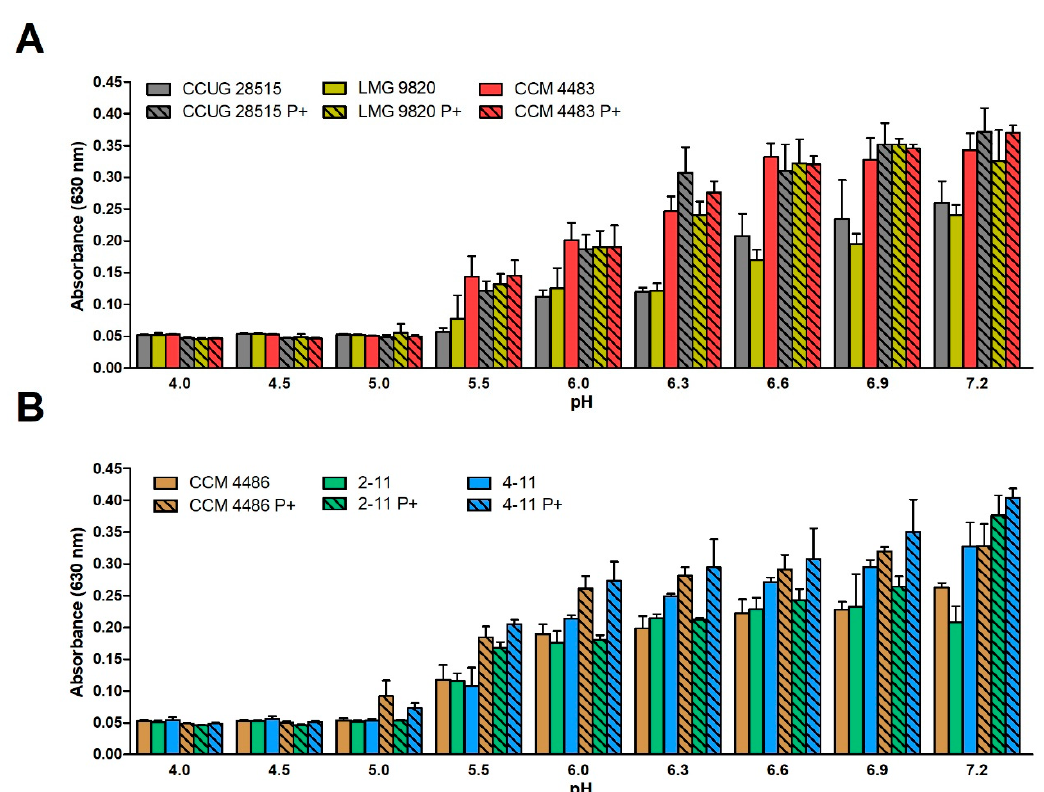
Figure 1. Growth of selected Paenibacillus larvae strains representing two environmentally significant Enterobacterial Repetitive Intergenic Consensus (ERIC) genotypes at various pH in MYPGP media. ( A ) ERIC I genotype, ( B ) ERIC II genotype. P+ indicates the growth of bacteria in MYPGP+P medium containing the buffering compound PIPES. Data are expressed as mean values with standard deviations.